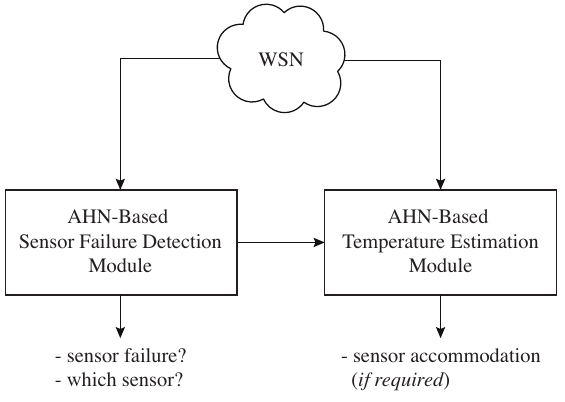
Figure 5. Proposed intelligent system for temperature estimation and sensor failure